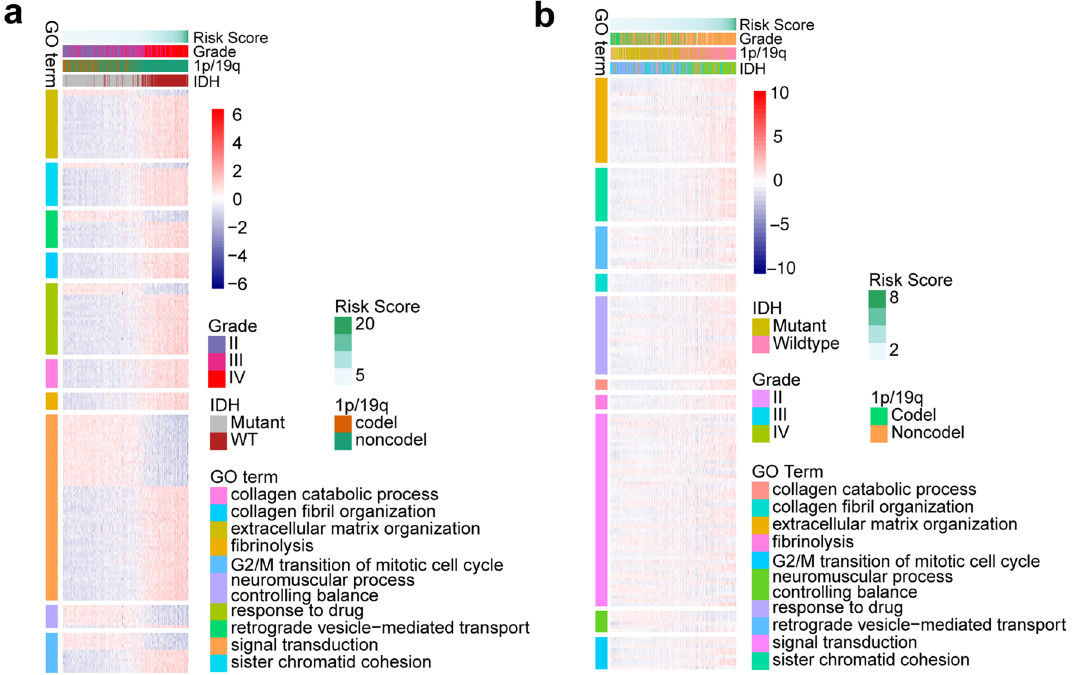
Figure 5. The biological functions of cell aging-related genes in the TCGA ( a ) and CGGA ( b )